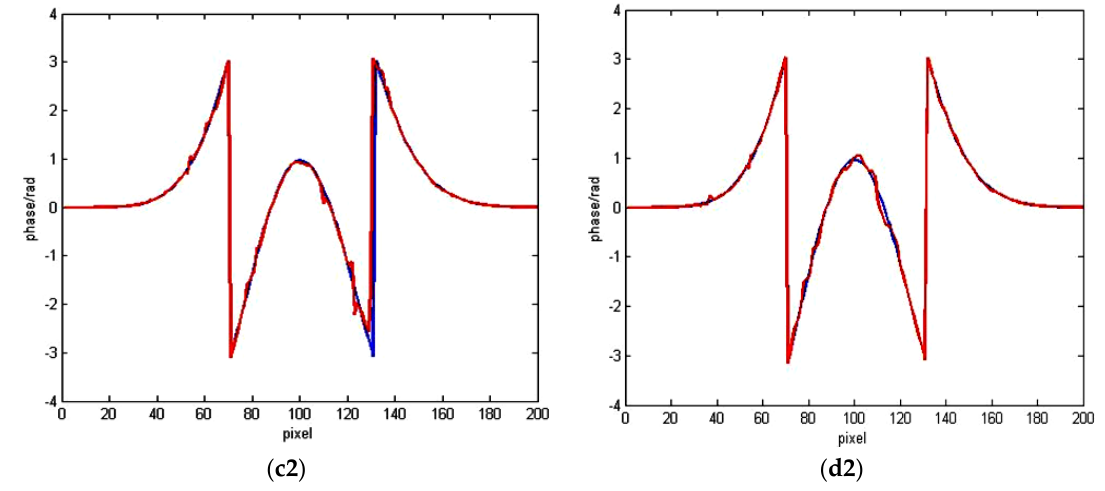
Figure 12. Deformation results of ( a1 ) the Goldstein filter; ( b1 ) the wavelet filter; ( c1 ) the Lee filter; and ( d1 ) the proposed filter; ( a2 – d2 ) Cross-section over the estimated deformation phase; the location of the cross-section is shown in ( a1 – d1 ). (Unit: rad).